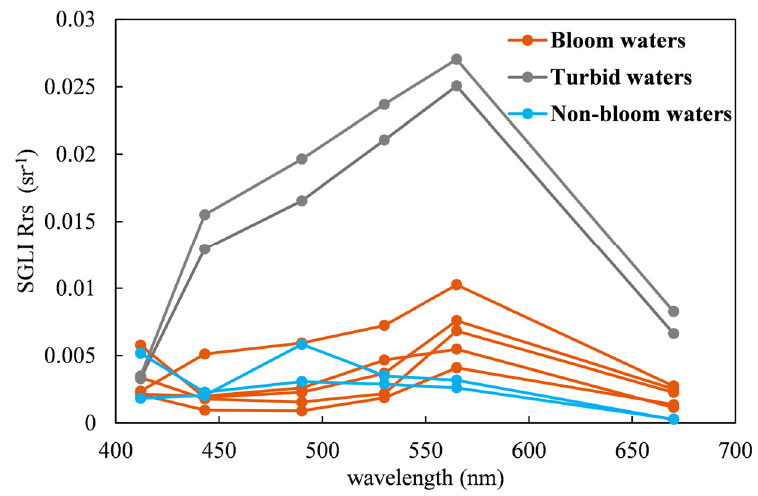
Figure 4. Satellite R rs ( λ ) of match-up pairs with local bloom records. The orange lines indicate values corresponding to bloom waters, whereas blue lines and gray lines represent clear and turbid waters, respectively.